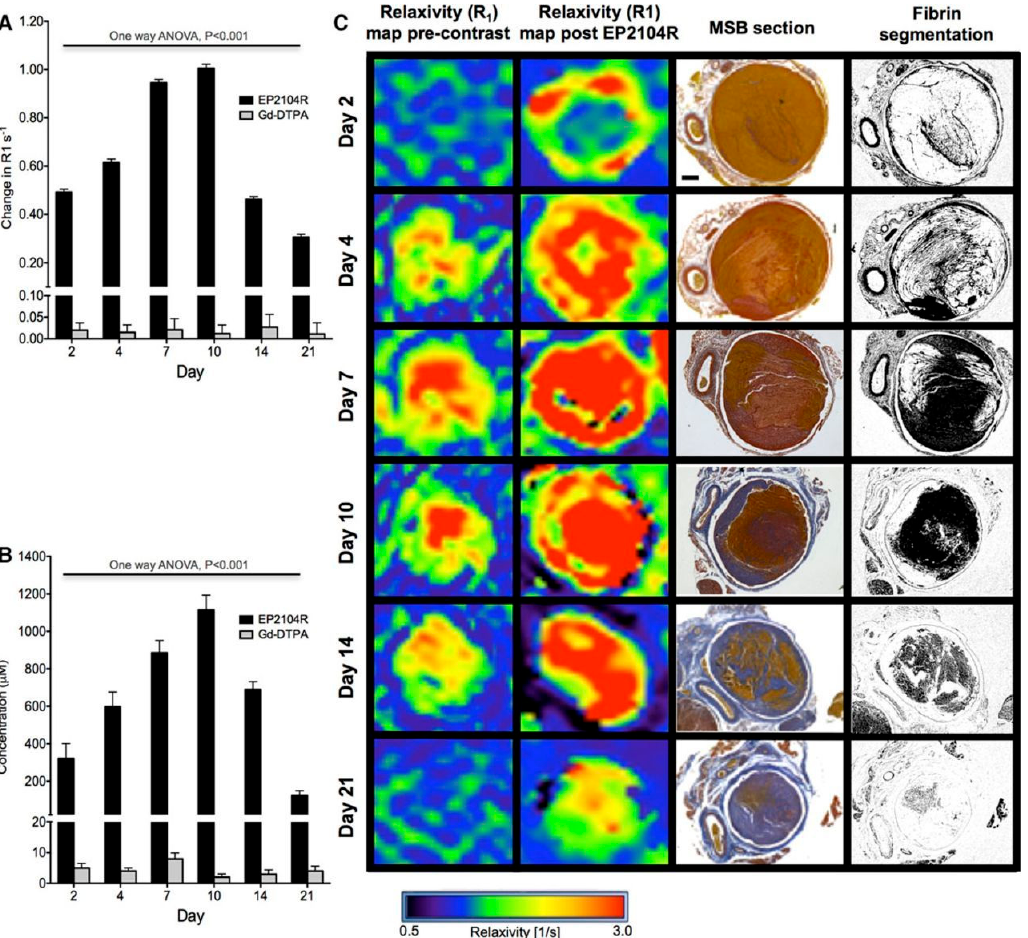
Figure 22. ( A ), Changes in thrombus relaxation rate Δ R1 (s-1) pre–EP-2104R and post–EP-2104R administration at different time point during thrombus organization. Greatest differences in Δ R1 pre and post contrast are observed at days 7 and 10. ( B ), Thrombus gadolinium concentration ( μ mol/L) mirrored the changes in R1 over time. ( C ), R1mapping images pre EP-2104R and post EP-2104R injection and Martius Scarlet Blue (MSB) histology sections at the corresponding levels and fibrin selective segmentation. Gd-DTPA indicates gadolinium with diethylenetriaminepentacetate (Magnevist, Schering AG, Berlin, Germany). Reproduced with permission from Andia et al., 2014 [138].